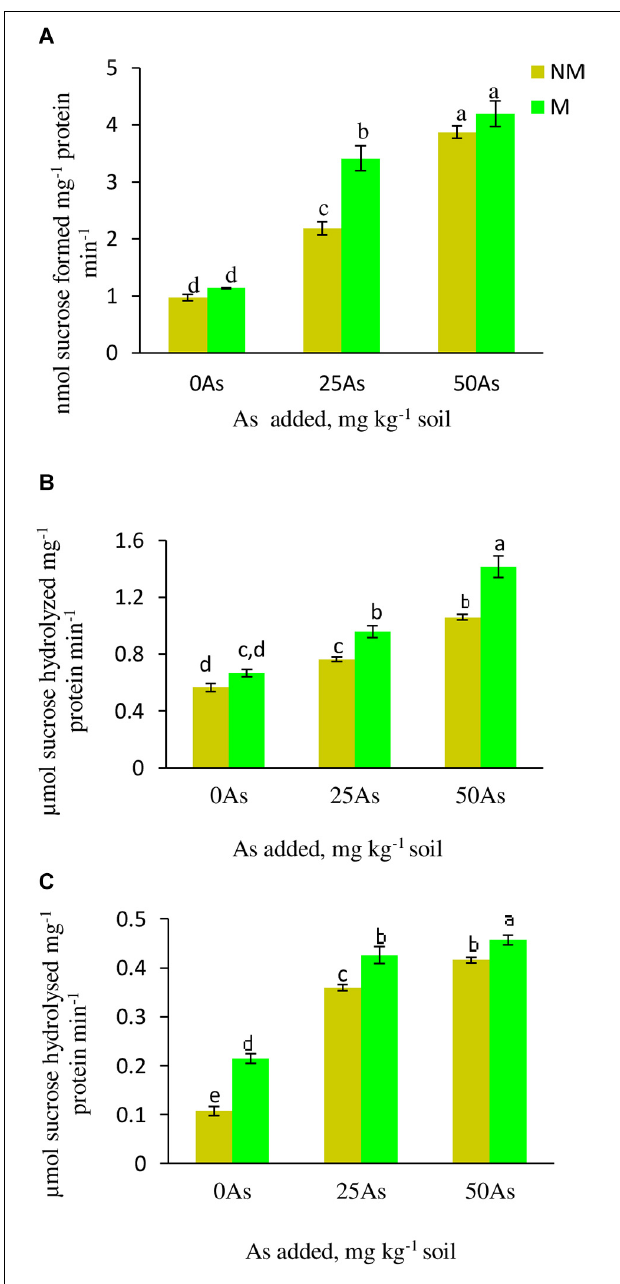
FIGURE 4 | Activity of sucrose metabolizing enzymes (A) sucrose phosphate synthase, SPS; (B) sucrose synthase, SS; and (C) acid invertase, AI, in leaves of Triticum aestivum in response to Rhizophagus intraradices inoculation (M, mycorrhizal; NM, non-mycorrhizal) and As addition to the soil. Values represent means of three biological replicates ± SD. Different letters represent significant difference at p ≤ 0.05 , derived from Tukey’s honestly significant difference (HSD). 0As, 0 mg As kg − 1 soil treatment; 25As, 25 mg As kg − 1 soil treatment; 50As, 50 mg As kg − 1 soil treatment.